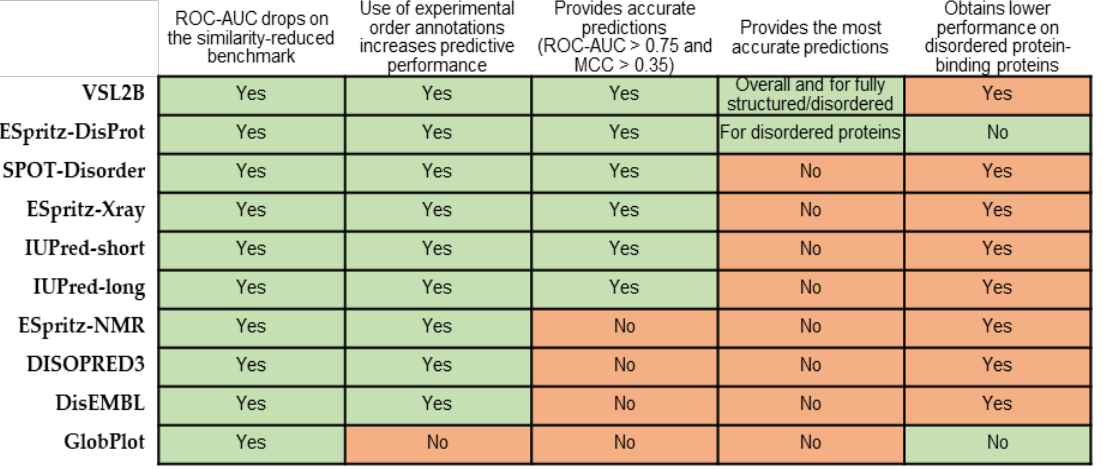
Figure S1: Distribution of the AUCs (panel A) and MCCs (panel B) over nine disorder predictors, Table S1: Predictive performance on the disorder-content equalized subset of the benchmark dataset, the disordered nucleic-acids binding proteins, and the disordered protein-binding proteins, Benchmark Dataset: Each protein is described using five lines that represent amino acid sequence, disorder annotation, disordered protein binding annotation, and disordered nucleic acid binding